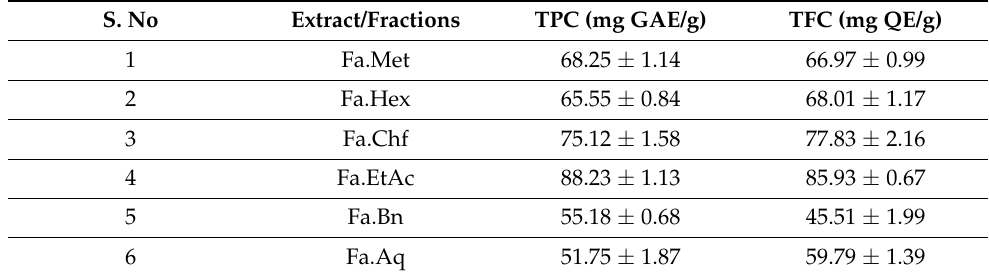
Table 3. Total Phenolic Content and Flavonoids Content in the extracts/fractions of Ferula ammoni- acum (D.